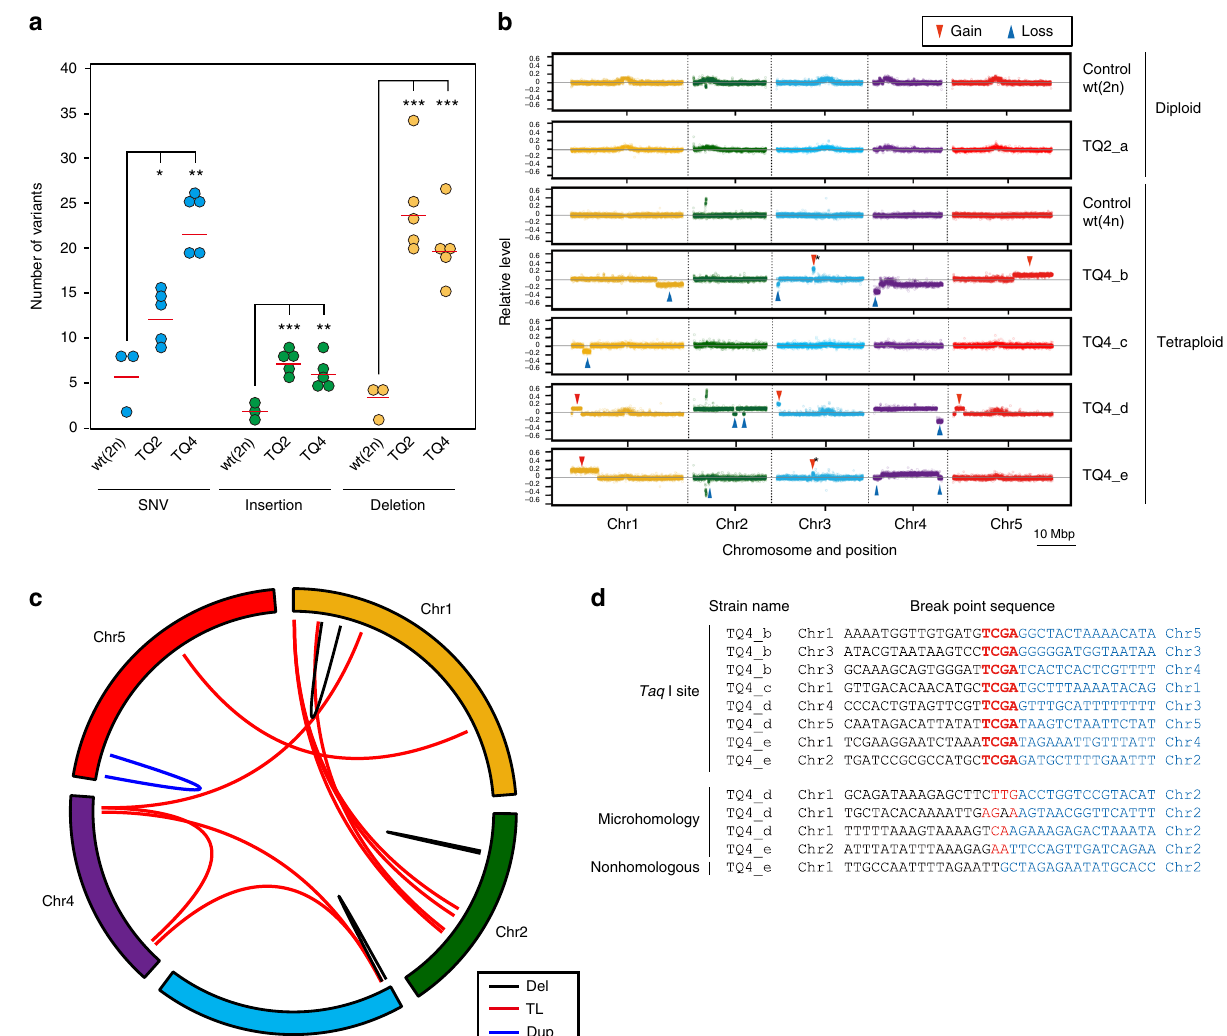
Fig. 6 TaqI-induced large copy number variations (CNVs) and chromosome rearrangements in Arabidopsis plants. a Number of SNVs and InDels in TAQed diploid (TQ2) and tetraploid (TQ4) progenies. Data represent the number of individual variants (dots) and the mean (red line) * P < 0.05, ** P < 0.01, *** P < 0.001; Welch ’ s t -test. b Array comparative genome hybridization (aCGH) karyotyping of TAQed diploid (TQ2_a) and tetraploid (TQ4_b-e) Arabidopsis plants with large CNVs and control plants [wt(2n) and wt(4n)]. Y axis exhibit relative fl uorescence intensity of log 10 (Cy5[sample]/Cy3[control]). Large CNVs (gain) in the upper arm of Chr3, indicated by an asterisk, were excluded from subsequent analysis because they occurred independently in multiple progenies. c Circular ideogram showing all TLs and large deletions identi fi ed in four TQ4 strains. d Breakpoint sequences in TAQed tetraploids with large CNV events. Consensus sequences are shown in